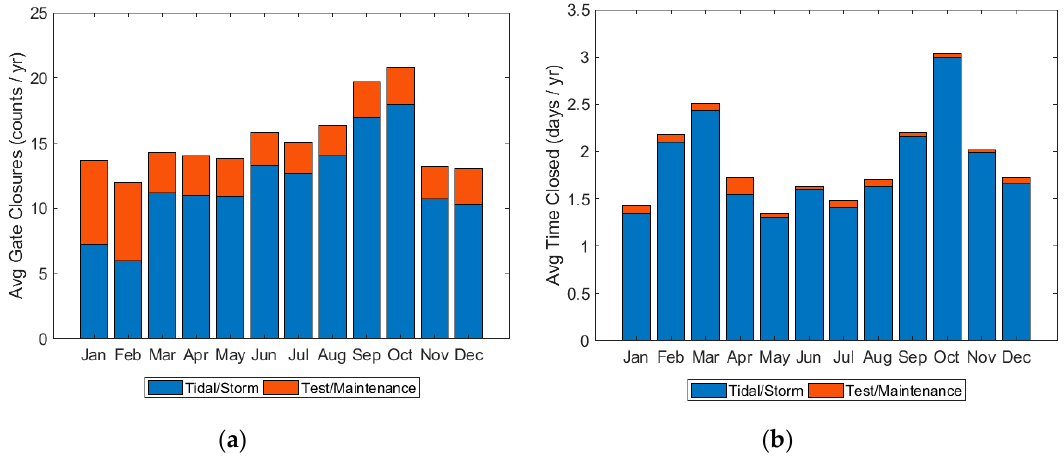
Figure 5. Average number of gate closures ( a ) and duration of closures per year ( b ) during each month based on gate closure data from 2007 to